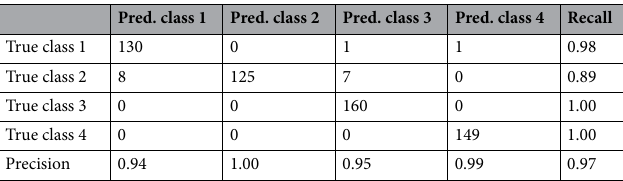
Table 3. Classification model’s performance when features are ABAs.